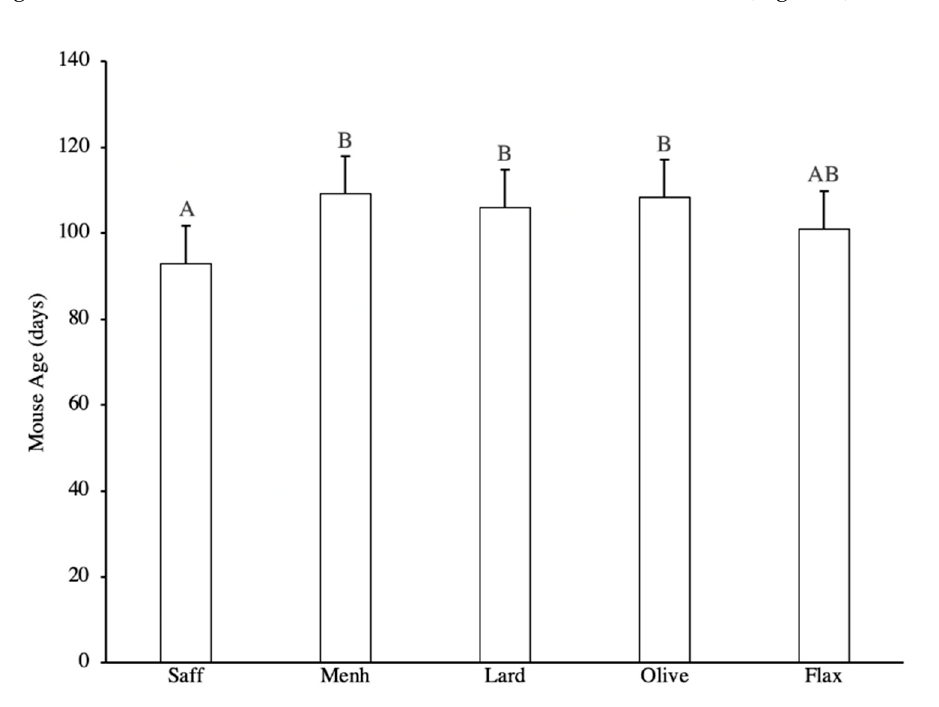
Figure 2. Proportion of mice that remained tumour free over the 20-week experimental period fed either 10% safflower oil diet ( n = 11), 3% menhaden oil diet ( n = 10), 3% flaxseed diet ( n = 9), 10% olive oil diet ( n = 6), or 10% lard diet ( n = 10). T50 denotes the time at which 50% of mice in a given group developed tumours. Groups with a different letter are significantly different as determined by repeated measures analysis ( p < 0.05).